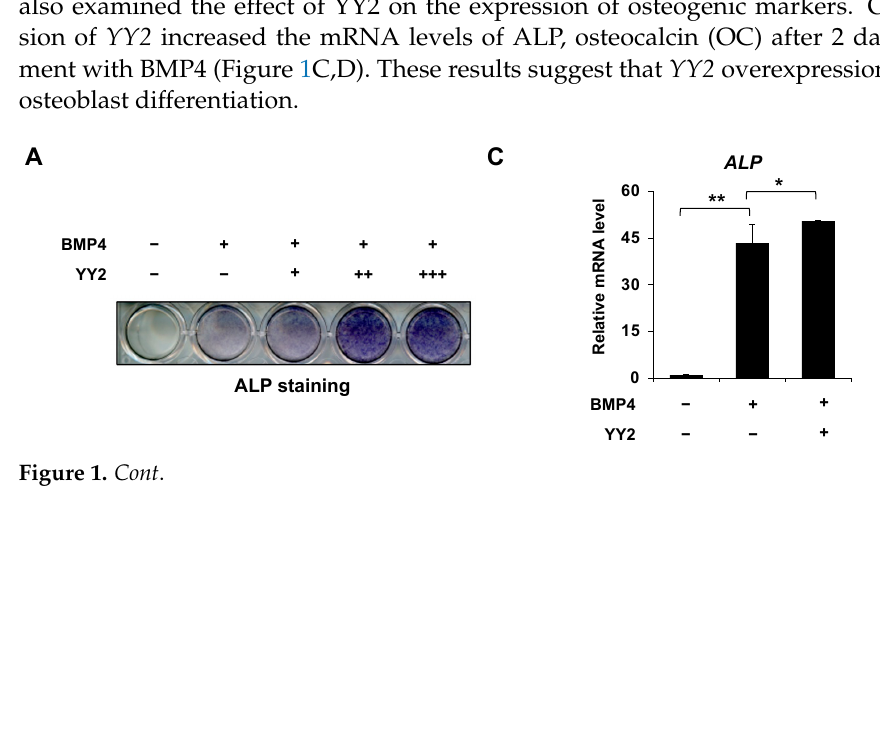
Figure 1. YY2 promotes BMP4-induced osteoblast differentiation. ( A , B ) Overexpression of YY2 significantly enhanced BMP4-induced expression of ALP in a dose-dependent manner. ALP stain- ing and quantitative analysis of ALP activity after empty vector or increasing amounts of YY2 transfected C2C12 cells treated with or without BMP4 for 72 h. ( C , D ) Overexpression of YY2 in- creased the mRNA levels of osteogenic marker genes such as ALP and OC.YY2 or empty vector- transfected C2C12 cells were stimulated with BMP4 for 48 h. The expression of ALP, OC is com- pared by RT-qPCR. Data are expressed as mean ± SEM of at least three experiments. * p < 0.05, ** p < 0.01. 2.2. Knockdown of YY2 Attenuated Osteoblast Differentiation To confirm our findings, we examined the effect of YY2 knockdown on osteoblast differentiation. The efficiency of the inhibition of endogenous YY2 was described previ- ously [19]. First, YY2 knockdown dramatically reduced BMP4-induced ALP activity (Figure 2A,B). Second, YY2 knockdown significantly decreased the mRNA expression of osteoblast differentiation markers, such as ALP and OC after 2 days of treatment with BMP4 (Figure 2C,D). These results suggest that YY2 knockdown inhibits osteoblast dif- ferentiation.